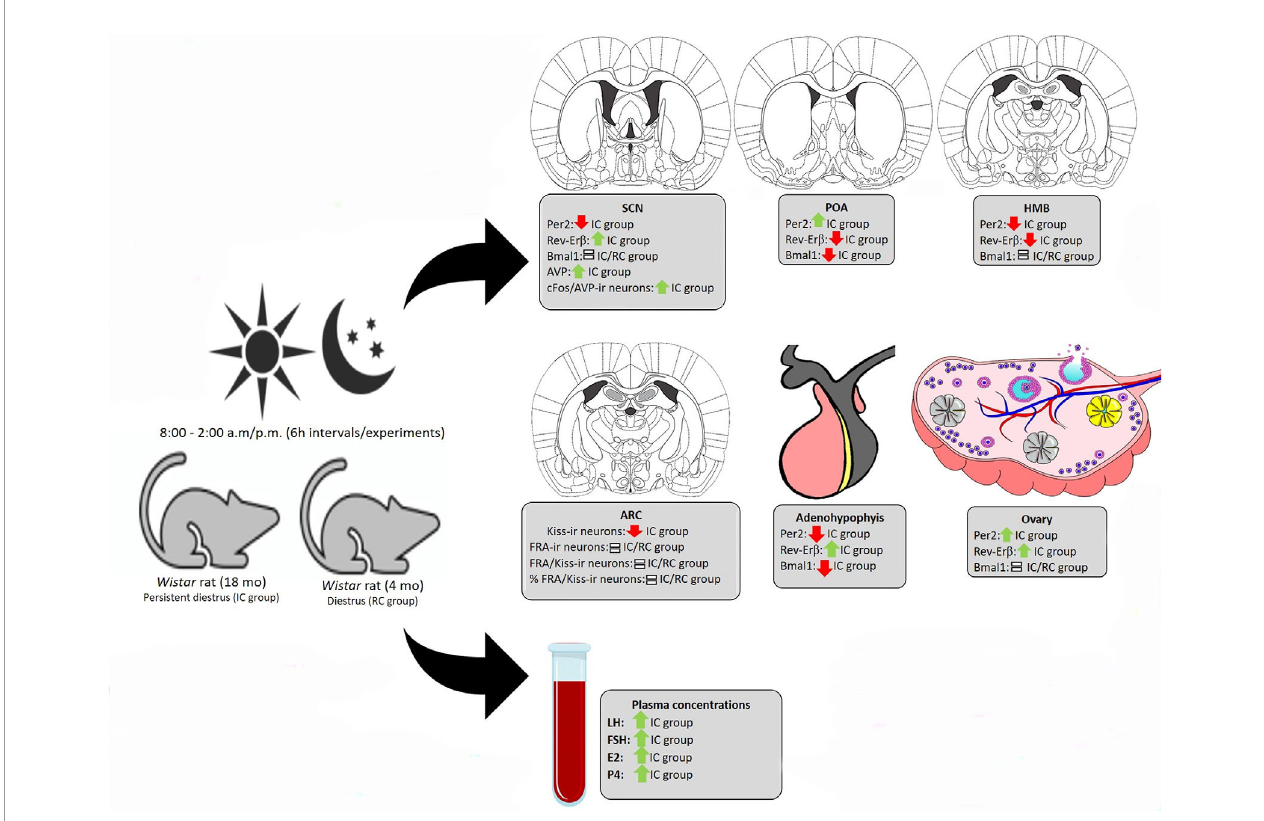
FIGURE 9 | Results summary. Expression pro fi le of clock genes on the HPG axis and activity of SCN AVP neurons and ARC Kiss neurons of rats in